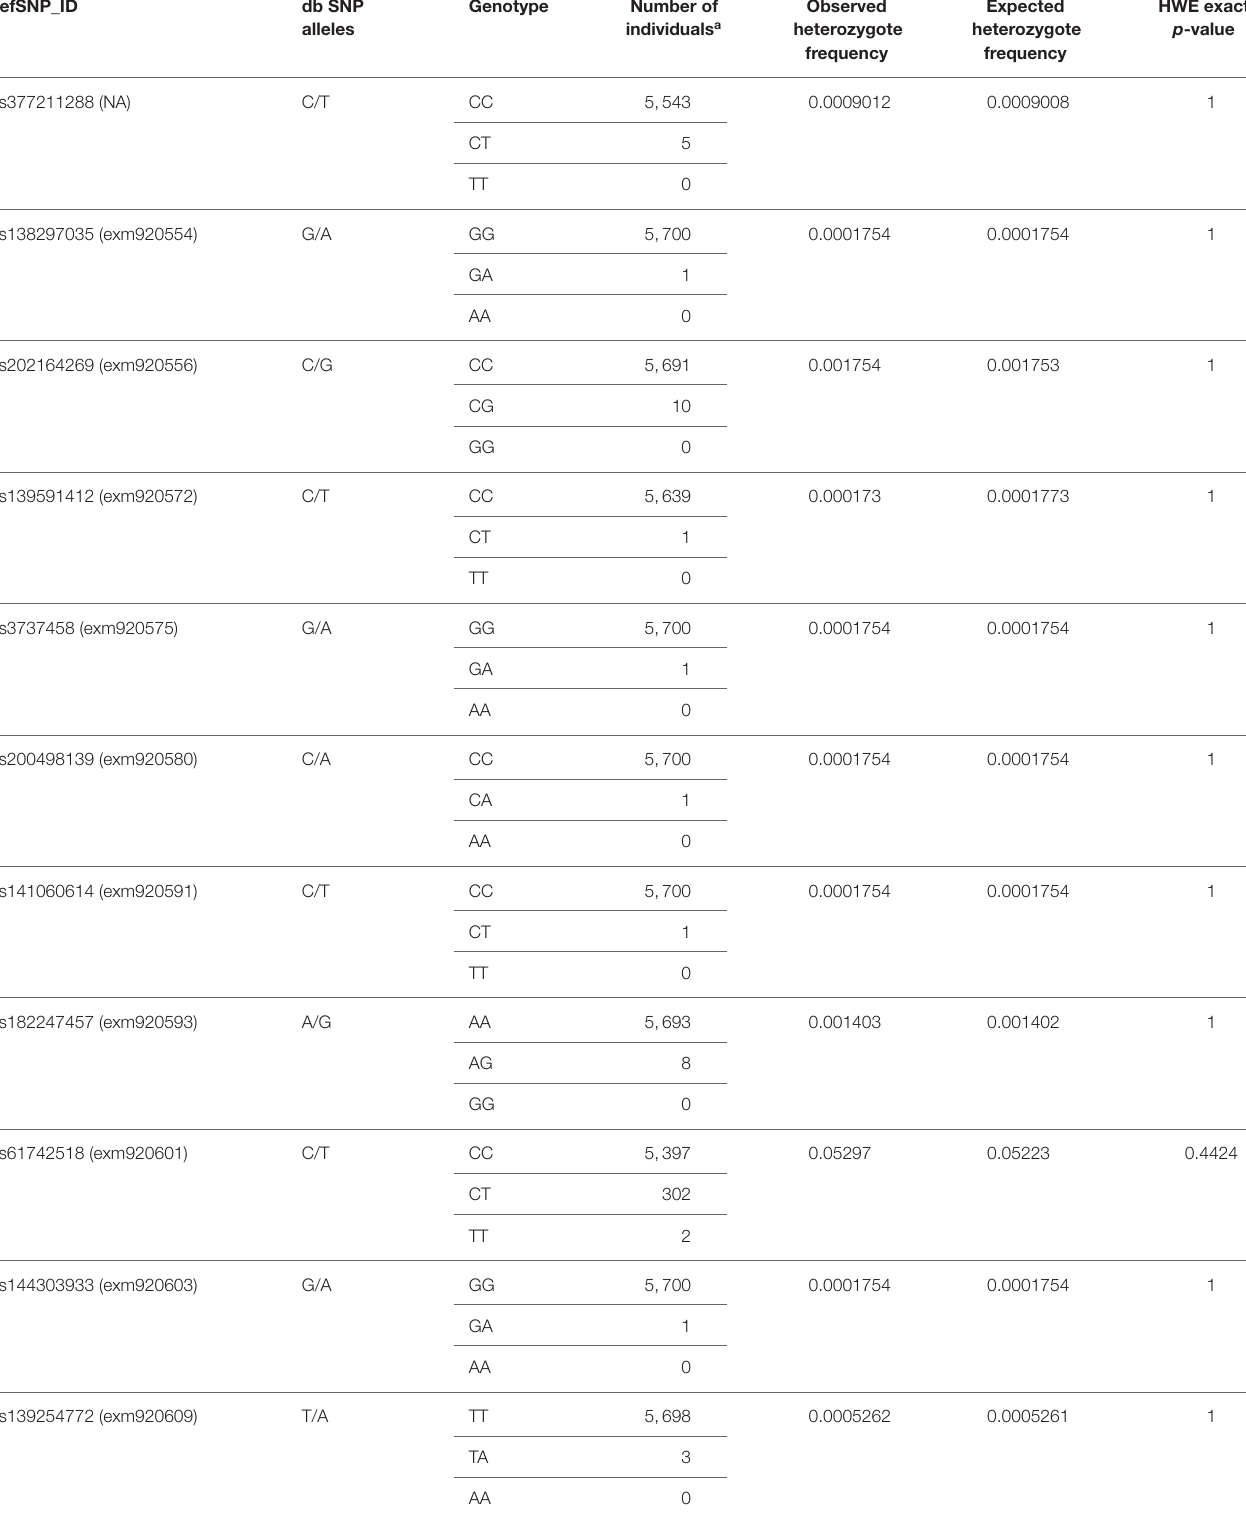
TABLE 3 | Genotype distributions for the 14 SLC22A9 genetic variants identified in the SHIP and SHIP-TREND study cohort. refSNP_ID db SNP